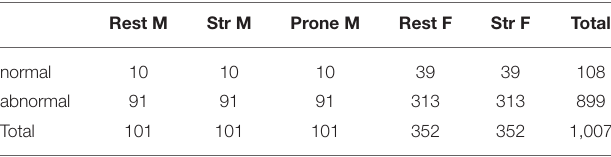
TABLE 1 | Polar maps